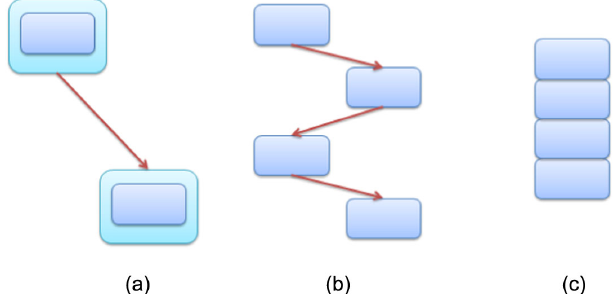
FIG. 1. The three CFDM structures: (a) accumulation around budding foci concepts; (b) zigzag between foci concepts; and (c) concept